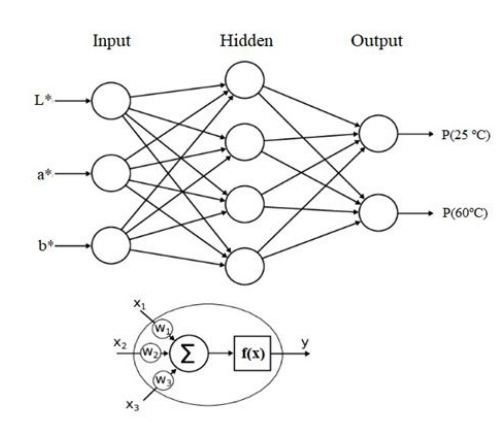
Figure 1. Schematic diagram of the MLP-ANN implemented in this work for study of the color changes of the CoHo:PGLyD with temperature. L*, a* and b* represents the spatial coordinates of the colors and P(25 ºC) and P(60 ºC) represent the probabilities in their respectives